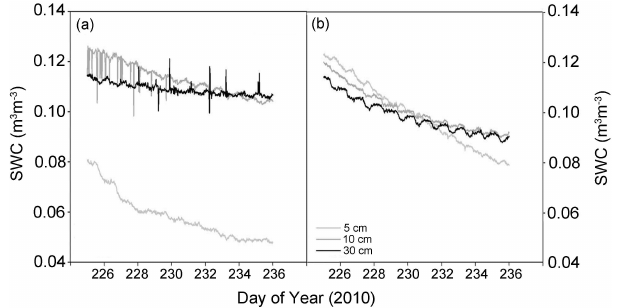
Fig. 5. Soil moisture at the (a) reference and (b) girdled sites ( n = 3 for each depth) during the girdled–reference comparison experi-